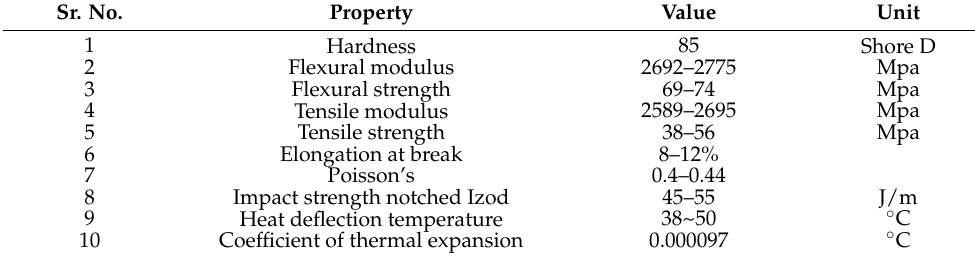
Table 4. The properties of resin.